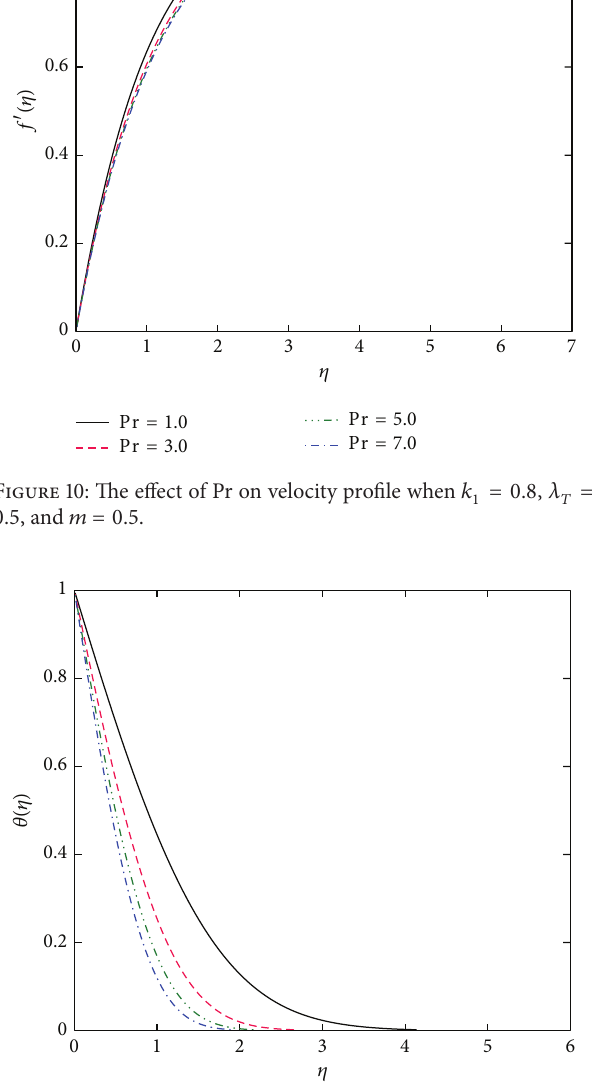
Figure 13: The effect of 𝑚 on temperature profile when 𝑘 1 = 1.0 , = 0.2 , and Pr = 1.0 𝜆 𝑇